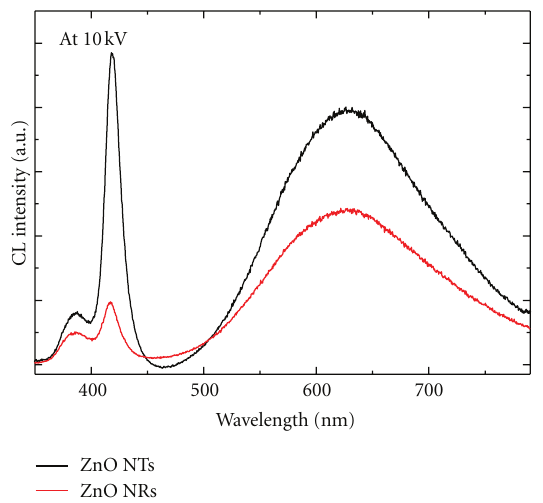
Figure 5: The comparison of the CL spectra of ZnO NTs and ZnO NRs.